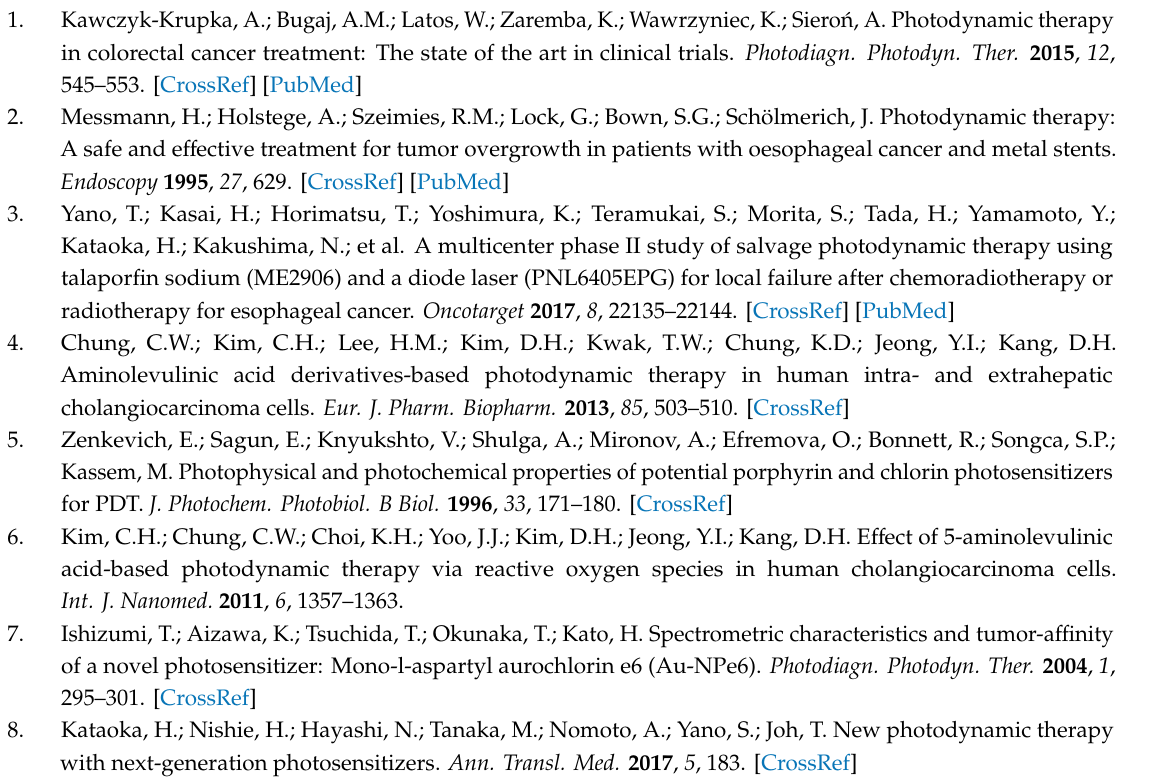
Figure S1: 1 H NMR spectra of Ce6 tetramer (a) and Ce6 decamer (b). For measurement of 1 H NMR (500 mHz) spectra, Ce6 tetramer and Ce6 decamer were dissolved in deuterated DMSO (DMSO d 6 ), Figure S2: 1 H NMR spectra of Ce6 tetramer–MePEG 2K conjugates (a) and Ce6 decamer-MePEG 5K conjugates (b). For